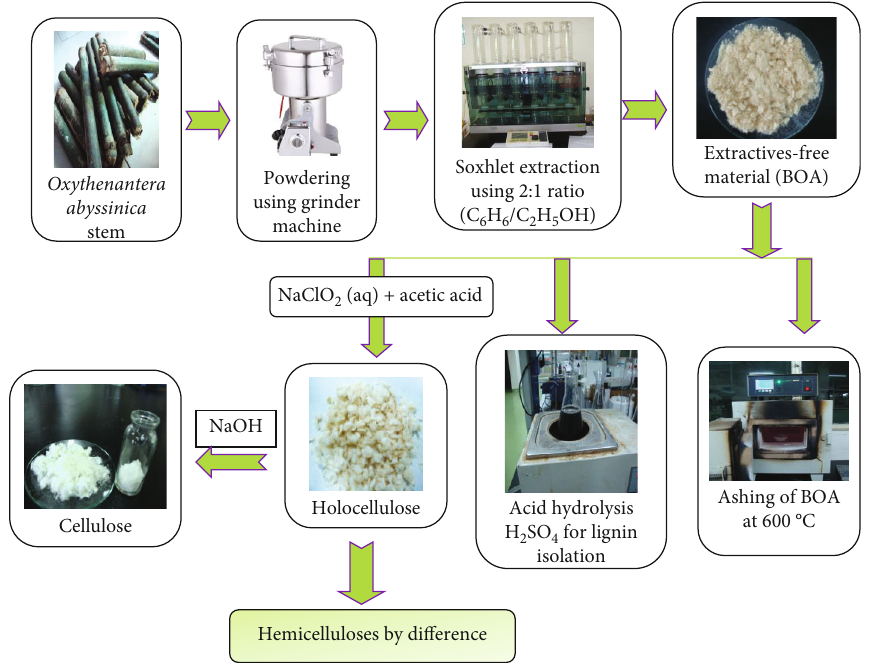
Figure 2: Chemical composition analysis